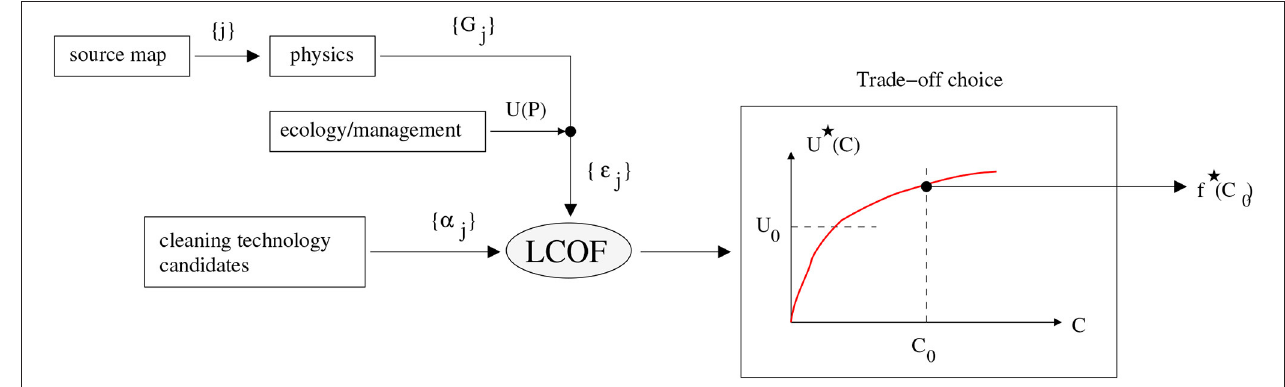
FIGURE 1 | Information flow in the litter cleanup optimization framework (LCOF), showing the emergence of the optimal cleanup solution f ⋆ for a type 2 analysis, in this case corresponding to a given budget C 0